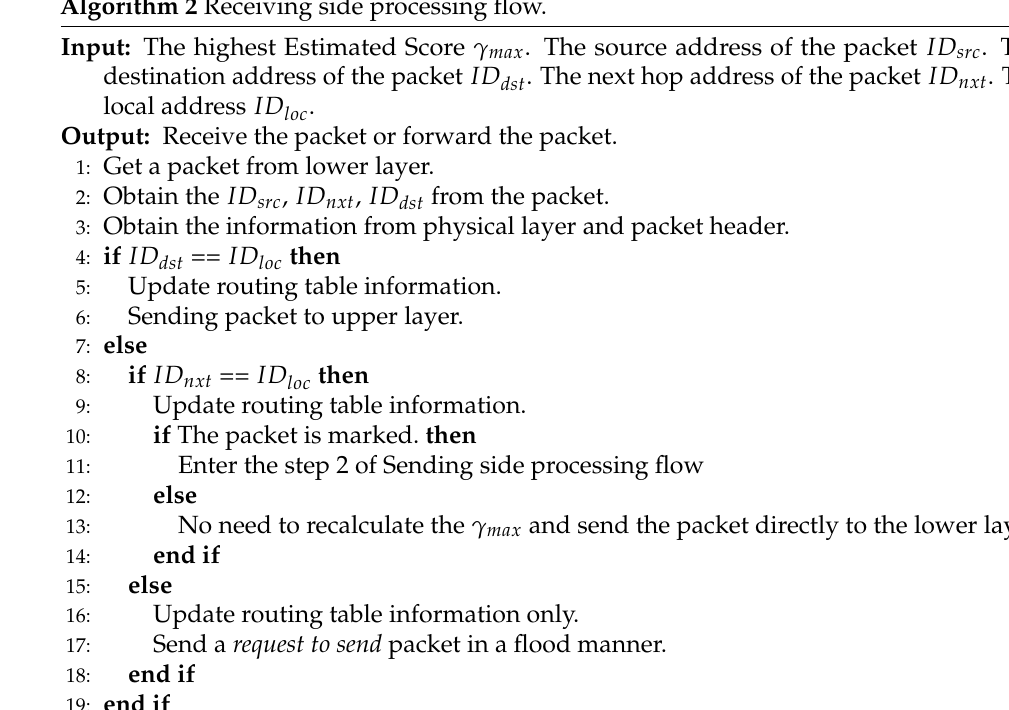
Algorithm 2 Receiving side processing